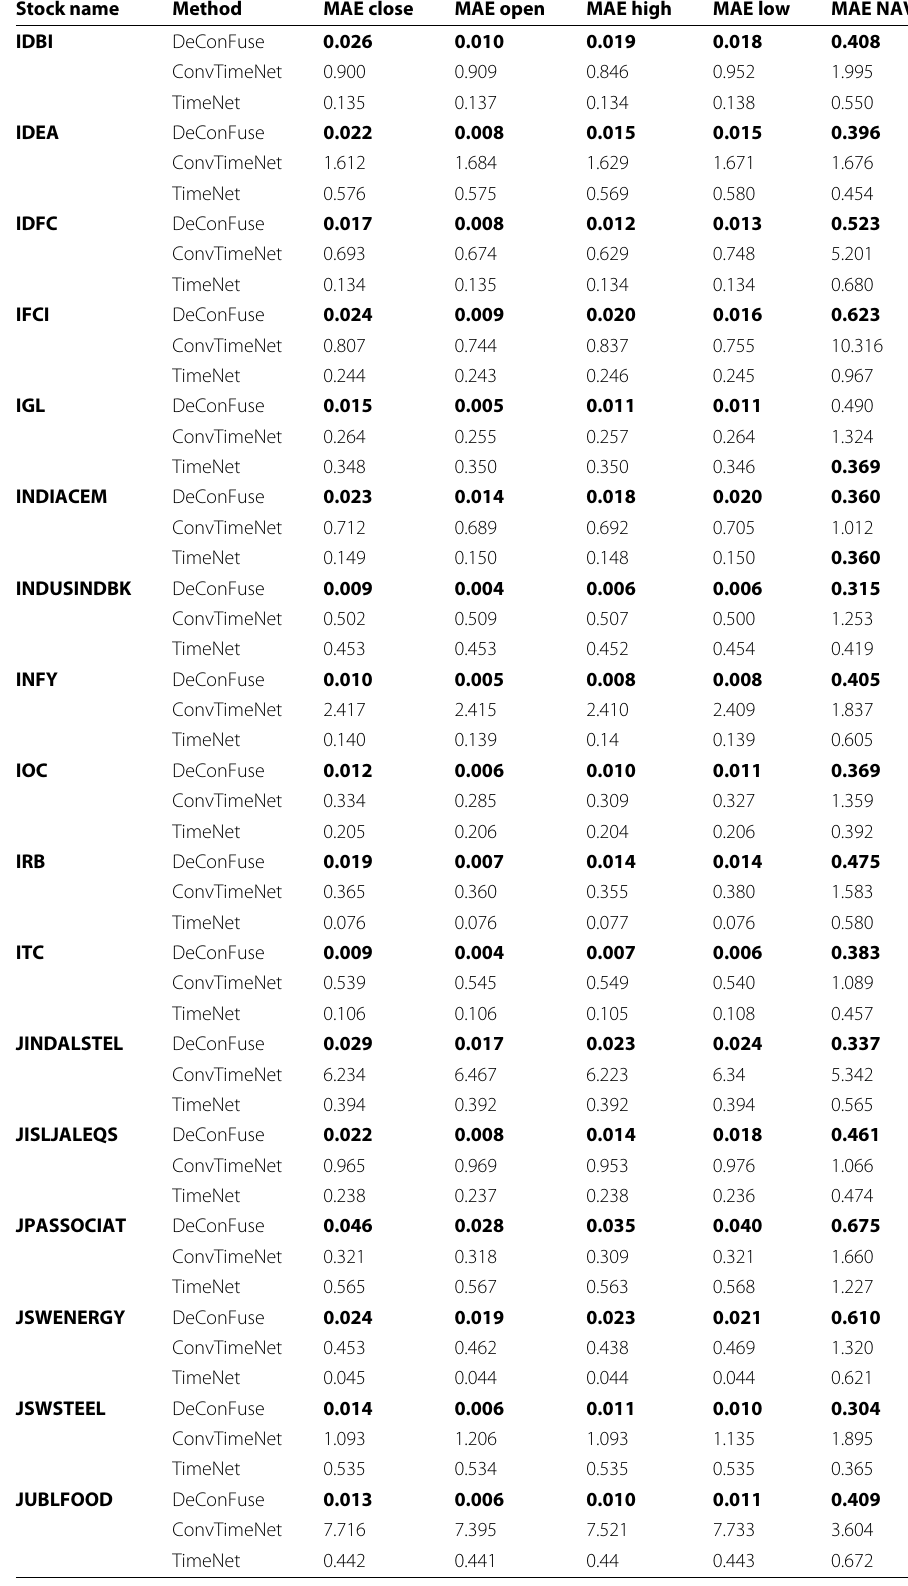
Table 5 Stock-wise forecasting results ( Continued